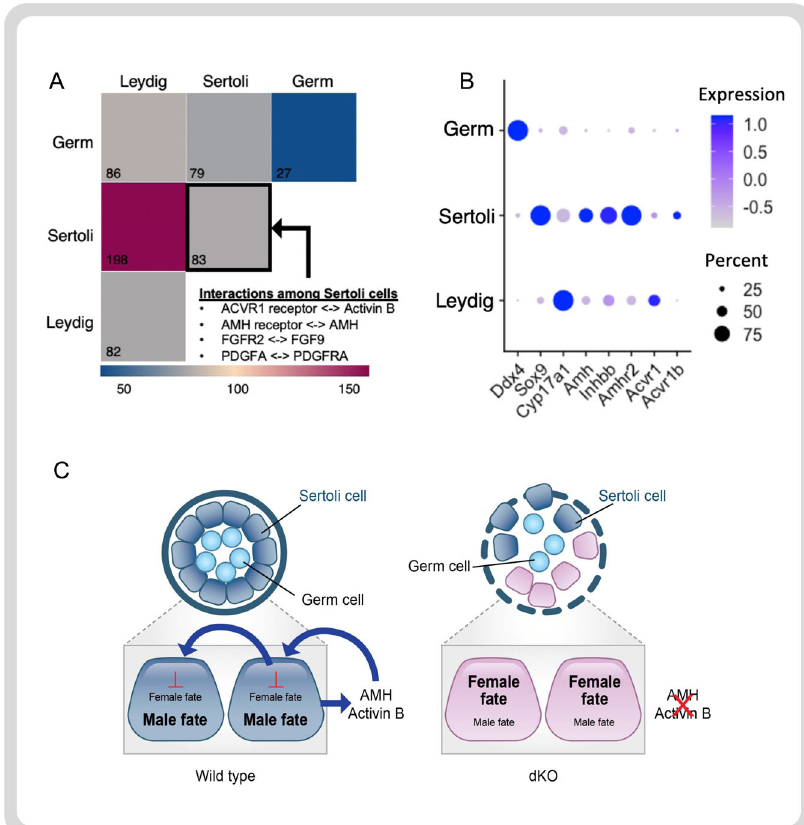
Fig. 5 Autocrine/Paracrine action of AMH and activin B on Sertoli cells. A Statistical prediction of cell-cell communication via ligand and receptor interaction among germ cells, Sertoli cells, and Leydig cells from the single cell RNAseq dataset using CellPhoneDB. Each square in the 3 × 3 grid represents interaction between two cell types (germ vs germ, Sertoli vs Leydig, etc.). The number inside the square is the number of ligand/receptor pairs. Interactions for AMH, activin B and their receptors were signi fi cantly enriched among Sertoli cells (black outlined square; source data are provided as a Source Data fi le; n = 2 biologically independent samples per genotype). B Dot plots of the expression of Amh , Inhbb , and their receptors in germ cells, Sertoli cells, and Leydig cells. C Proposed model of the autocrine/paracrine action of AMH and Activin B. Sertoli cells secrete AMH and Activin B which act on an autocrine and paracrine way to block the female fate in the wild type Sertoli cells. In the absence of Amh and Activin B in the dKO, the cells become feminized at the testis